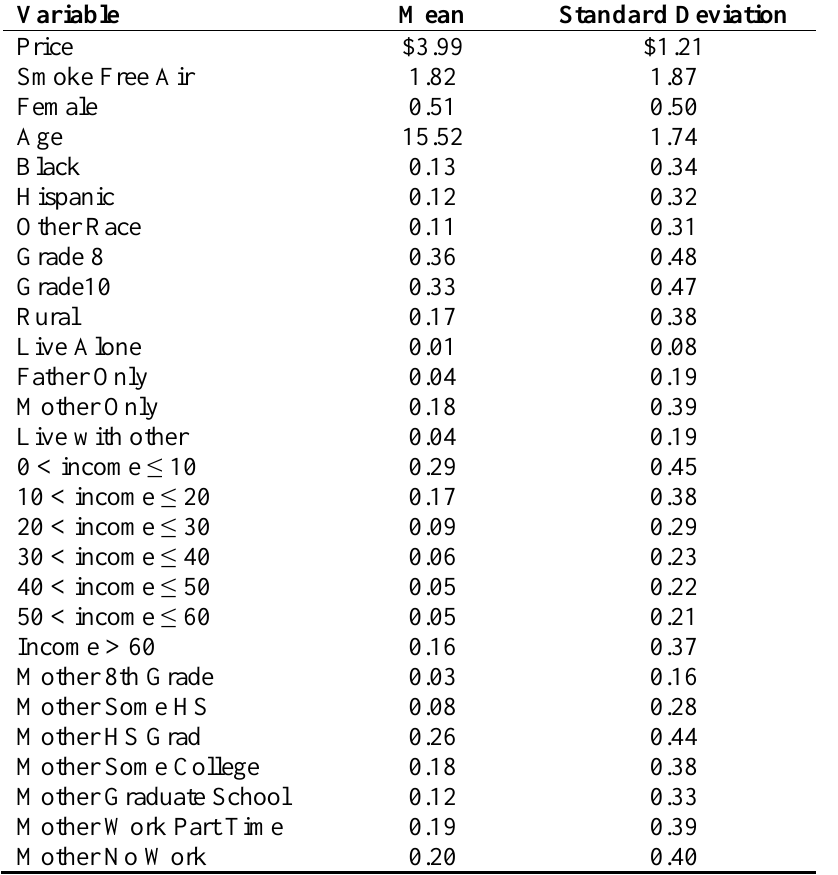
Table 1. Descriptive Statistics for Key Independent